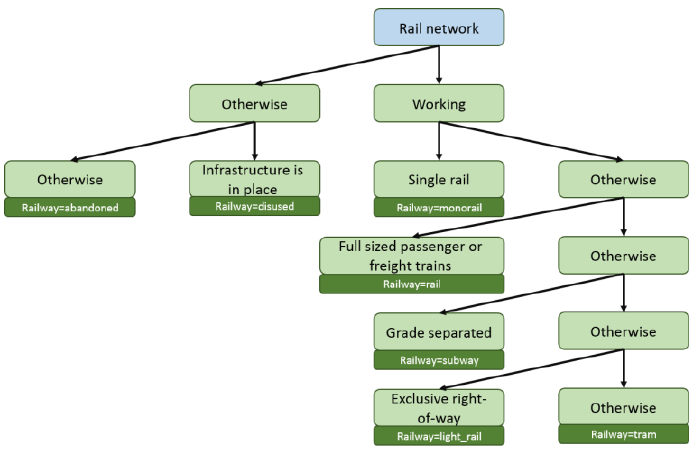
Figure 4. Expanded view of "Rail network" box in Figure 1.